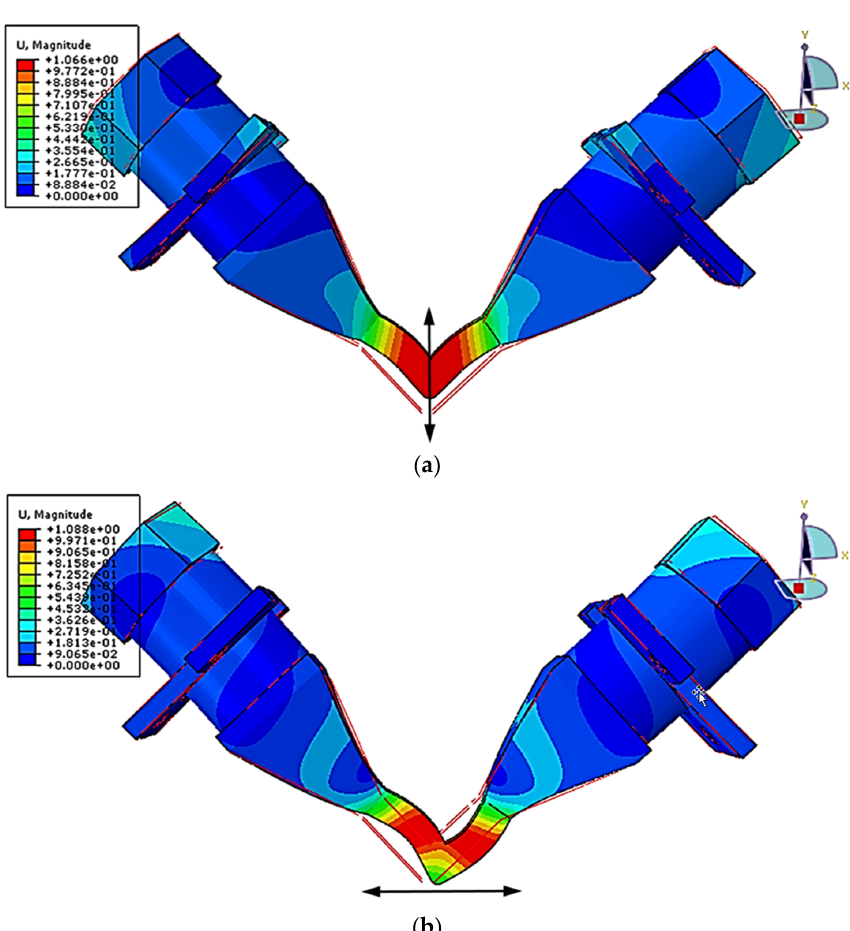
Figure 2. Vibration modes of the V ‐ shape stator of standing ‐ wave ultrasonic motors: ( a ) Symmetric mode, and ( b ) anti ‐ symmetric mode (the color system reads the modal displacement of V ‐ shape vibrator).